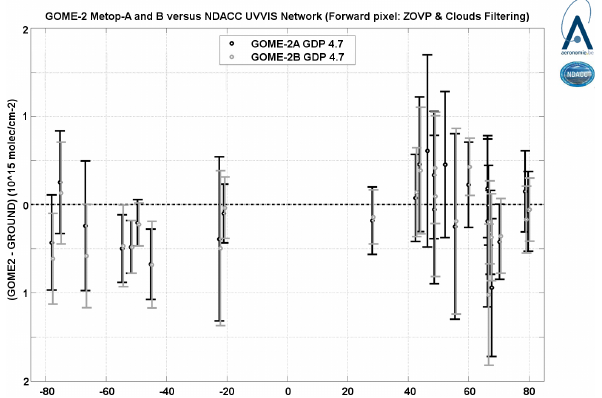
Figure 8. Example of total (stratospheric) NO 2 validation: Pole- to-pole structure of the median absolute difference between NO 2 column data retrieved from GOME-2A/B (GDP 4.7) and from 25 ground-based zenith-sky DOAS spectrometers archiving consoli- dated data to NDACC DHF, calculated over 2007–2014 for GOME- 2A and 2013–2014 for